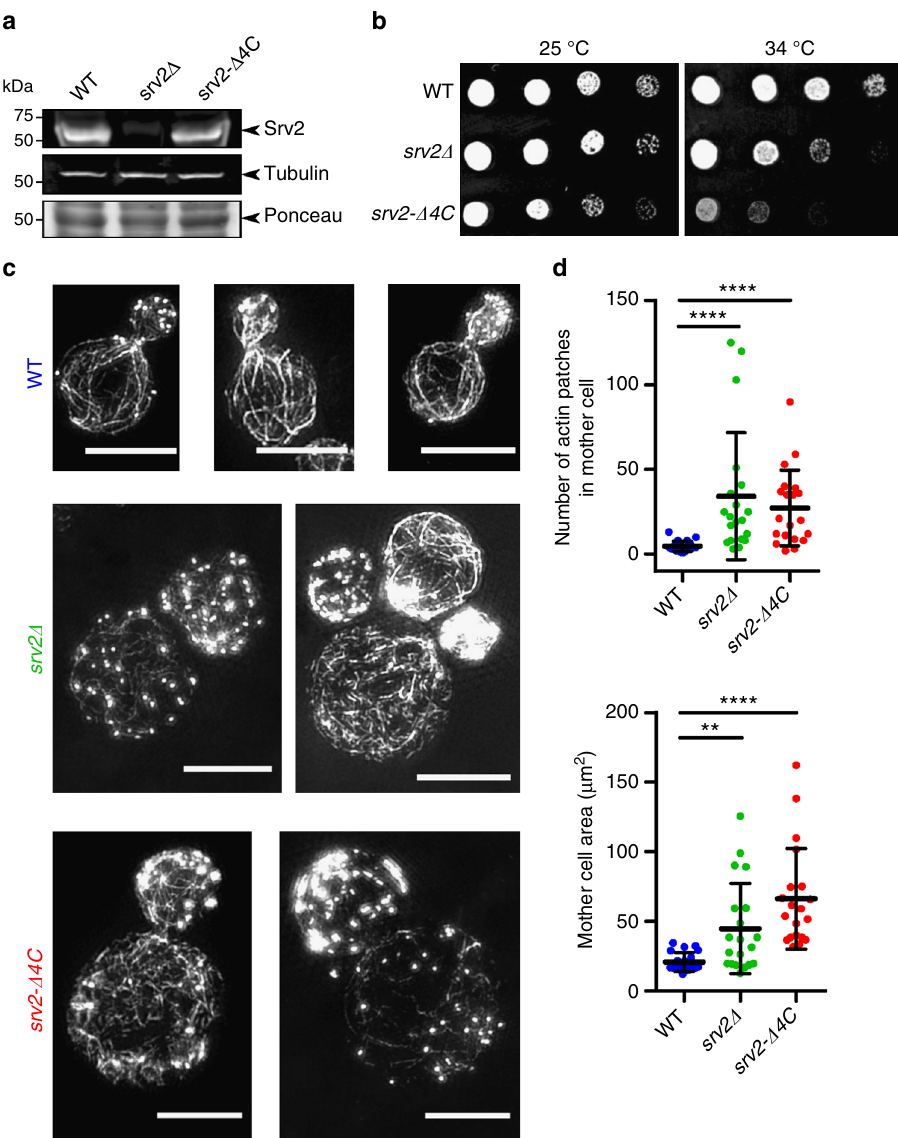
Fig. 5 Truncation of Srv2/CAP ’ s C-terminal tail severely compromises actin cytoskeleton. a Western blots showing Srv2 expression levels in yeast strains with tubulin immunoblotting and Ponceau staining as loading controls. See Supplementary Fig. 7 for uncropped images. b Five-fold serial dilutions of yeast strains grown on YEPD plates at the indicated temperatures. c Structured illumination microscopy (SIM) of fi lamentous actin networks in yeast cells. Cells were grown in YEPD at 25 °C, fi xed, and stained with Alexa488-phalloidin; scale bar, 5 µ m. d Quanti fi ed differences in actin patch number and cell size across indicated yeast strains; n = 20 cells per strain; One-way, non-parametric ANOVA, p < 0.01 (**) and p < 0.0001